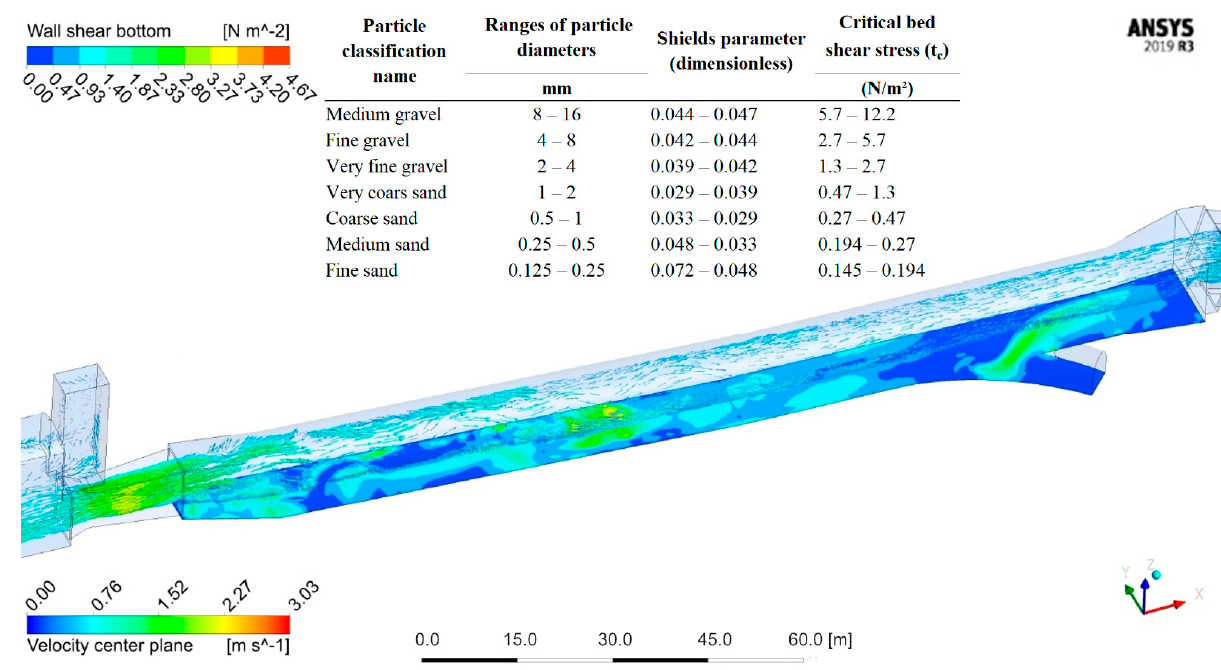
( b ) Figure 6. Transient simulation of the pressurized sand trap with focus on the inlet jet. The inlet flow boundary condition is from a separate approach flow simulation presented earlier. ( a ) Bottom shear stress and isosurface of 1 m/s (1.49 * aver- age sand trap velocity) for inlet discharge 80 m³/s. ( b ) Inlet boundary flow conditions, illustrating the transition from the concrete lined section to unlined section, resulting in a sudden expansion. This figure also shows the input section of particles (next chapter). Based on the simulated flow, the wall shear stress on the invert has been calculated in Ansys CFX. The transient 3D CFD simulation shows a highly transient behavior of the